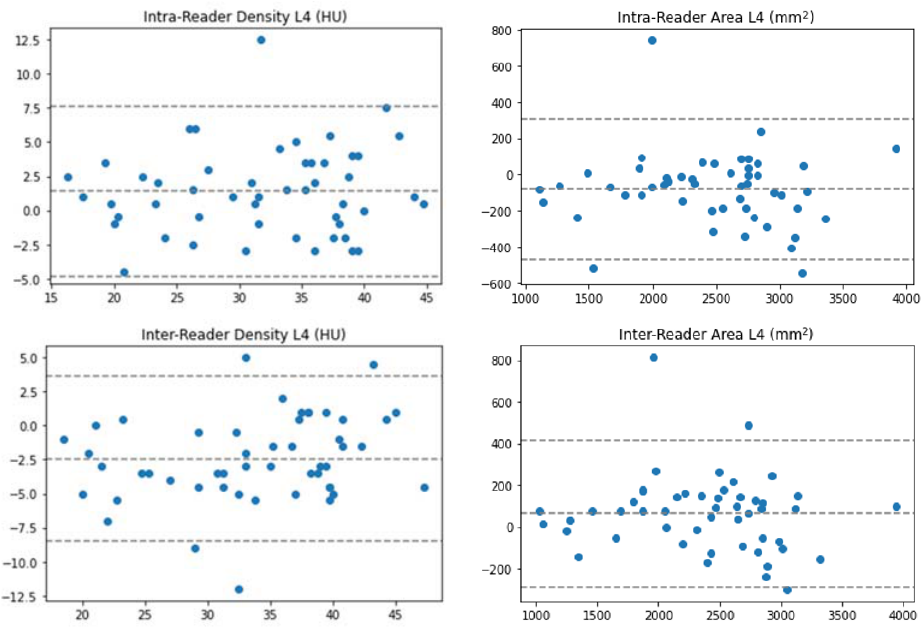
Figure 3. Bland–Altman plots for intra- and inter-reader reproducibility.